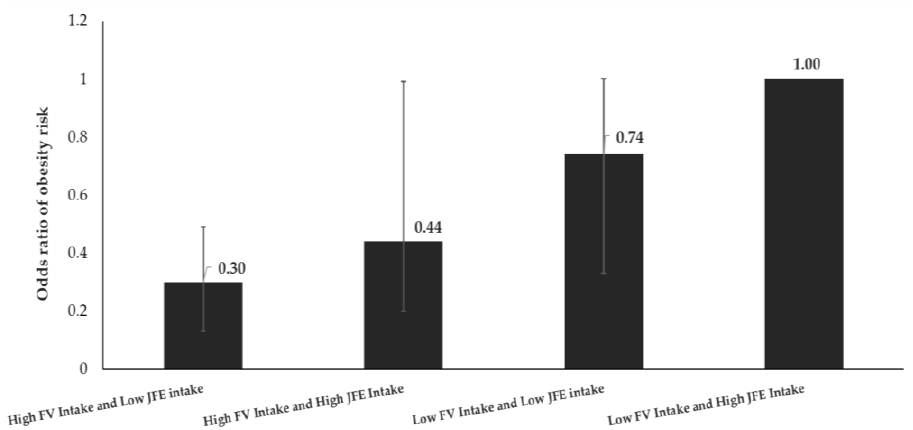
Figure 2. The interaction between fruit and vegetable intake and junk food energy intake. We generated the odds ratios and p -value from conditional multiple logistic regression after adjusting for sex, age of the child, residence, mother’s education, household expenditure, and TV ownership. FV is fruit and vegetable. JFE is junk food energy.